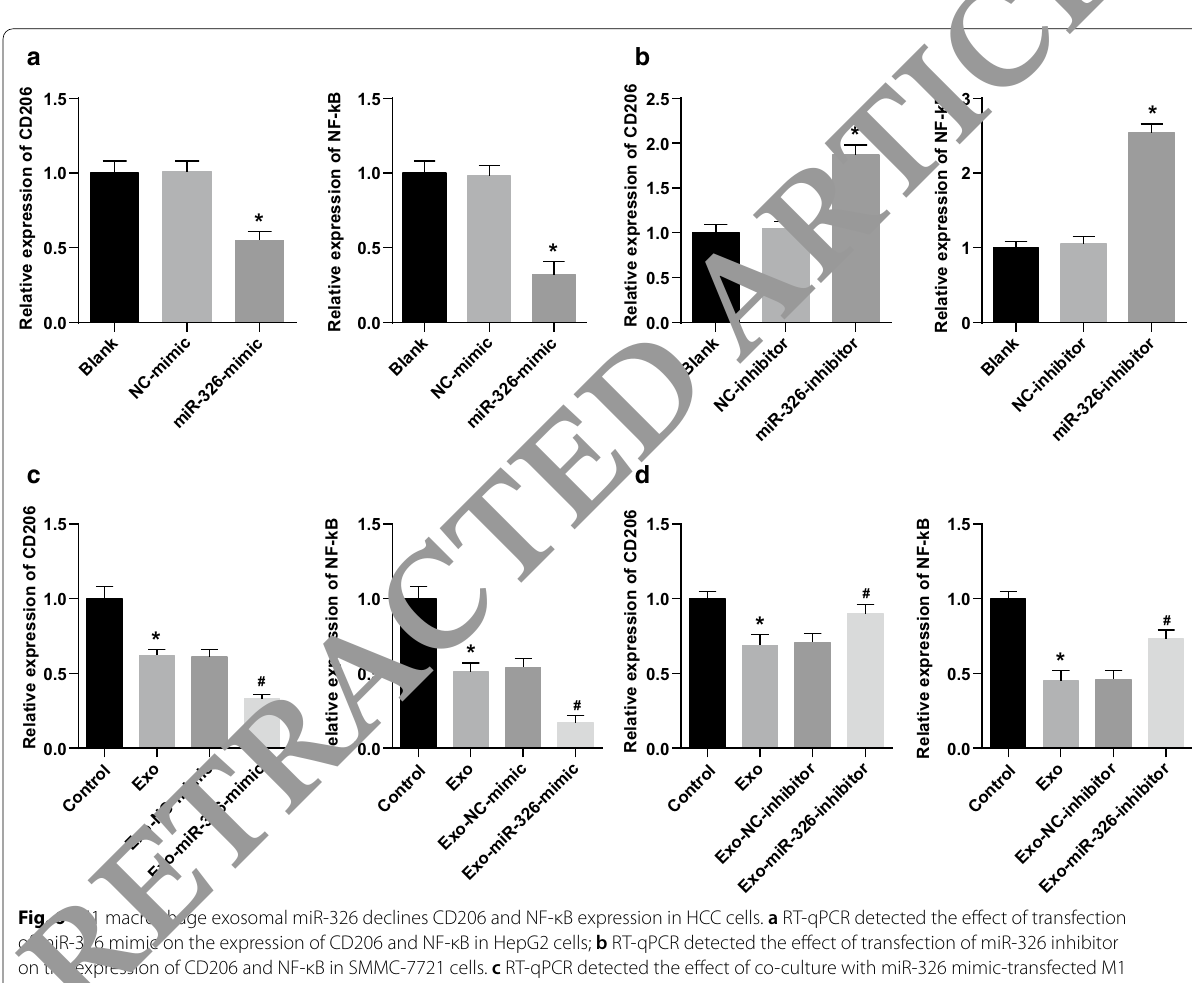
Fig. 6 M1 macrophage exosomal miR‑326 declines CD206 and NF‑κB expression in HCC cells. a RT‑qPCR detected the effect of transfection of miR‑326 mimic on the expression of CD206 and NF‑κB in HepG2 cells; b RT‑qPCR detected the effect of transfection of miR‑326 inhibitor on the expression of CD206 and NF‑κB in SMMC‑7721 cells. c RT‑qPCR detected the effect of co‑culture with miR‑326 mimic‑transfected M1 macrophage‑derived exosomes on the expression of CD206 and NF‑κB in HepG2 cells; d RT‑qPCR detected the effect of co‑culture with miR‑326 inhibitor‑transfected M1 macrophage‑derived exosomes on the expression of CD206 and NF‑κB in SMMC‑7721 cells. In panel a, * P < 0.05 versus the NC‑mimic group; In panel b, * P < 0.05 versus the NC‑inhibitor group; In panel c, * P < 0.05 versus the control group, # P < 0.05 versus the Exo‑NC‑mimic group; In panel d, * P < 0.05 versus the control group, # P < 0.05 versus the Exo‑NC‑inhibitor group. Measurement data were depicted as mean standard deviation ( N 3), comparisons among multiple groups were conducted by one‑way analysis of ± =